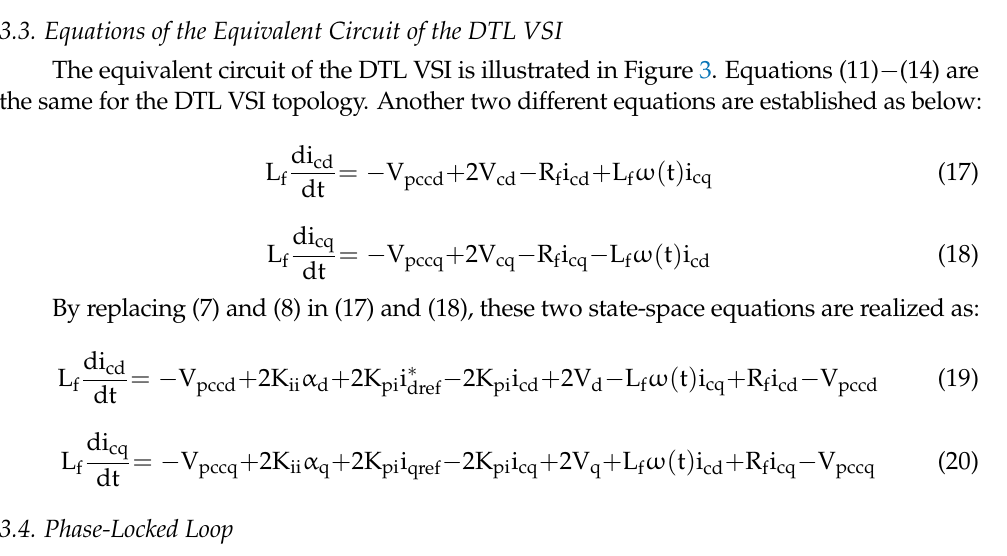
Figure 5. Two-level voltage source inverter (TL VSI) equivalent